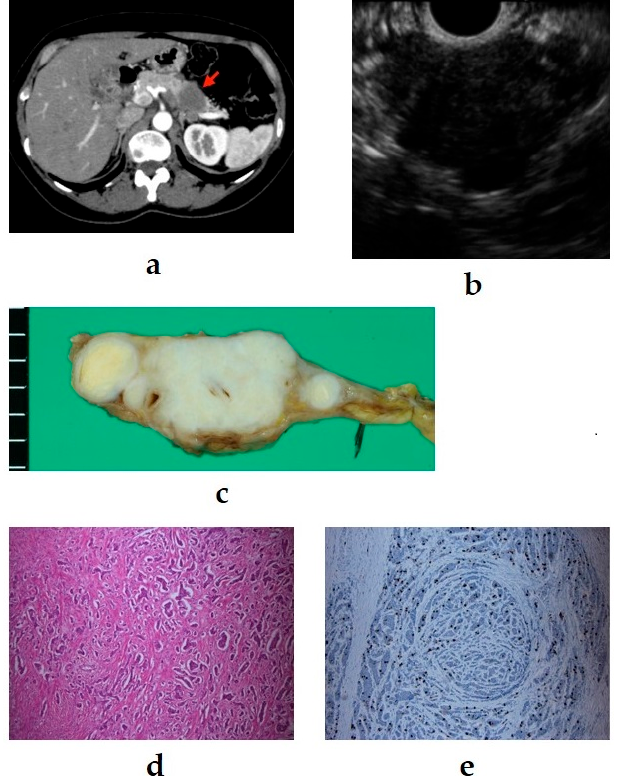
Figure 5. ( a ) Contrast-enhanced computed tomography (CT): an ill-defined mass (arrow) with a hypovascular enhancement pattern. The dilated pancreatic duct is notable. ( b ) Endoscopic ultrasound (EUS): irregular margins, unclear boundaries, and heterogeneous hypoechoic masses are shown. ( c , d , e ) Resected specimen: Ki-67 > 20%, neuroendocrine neoplasm G3 (100×).